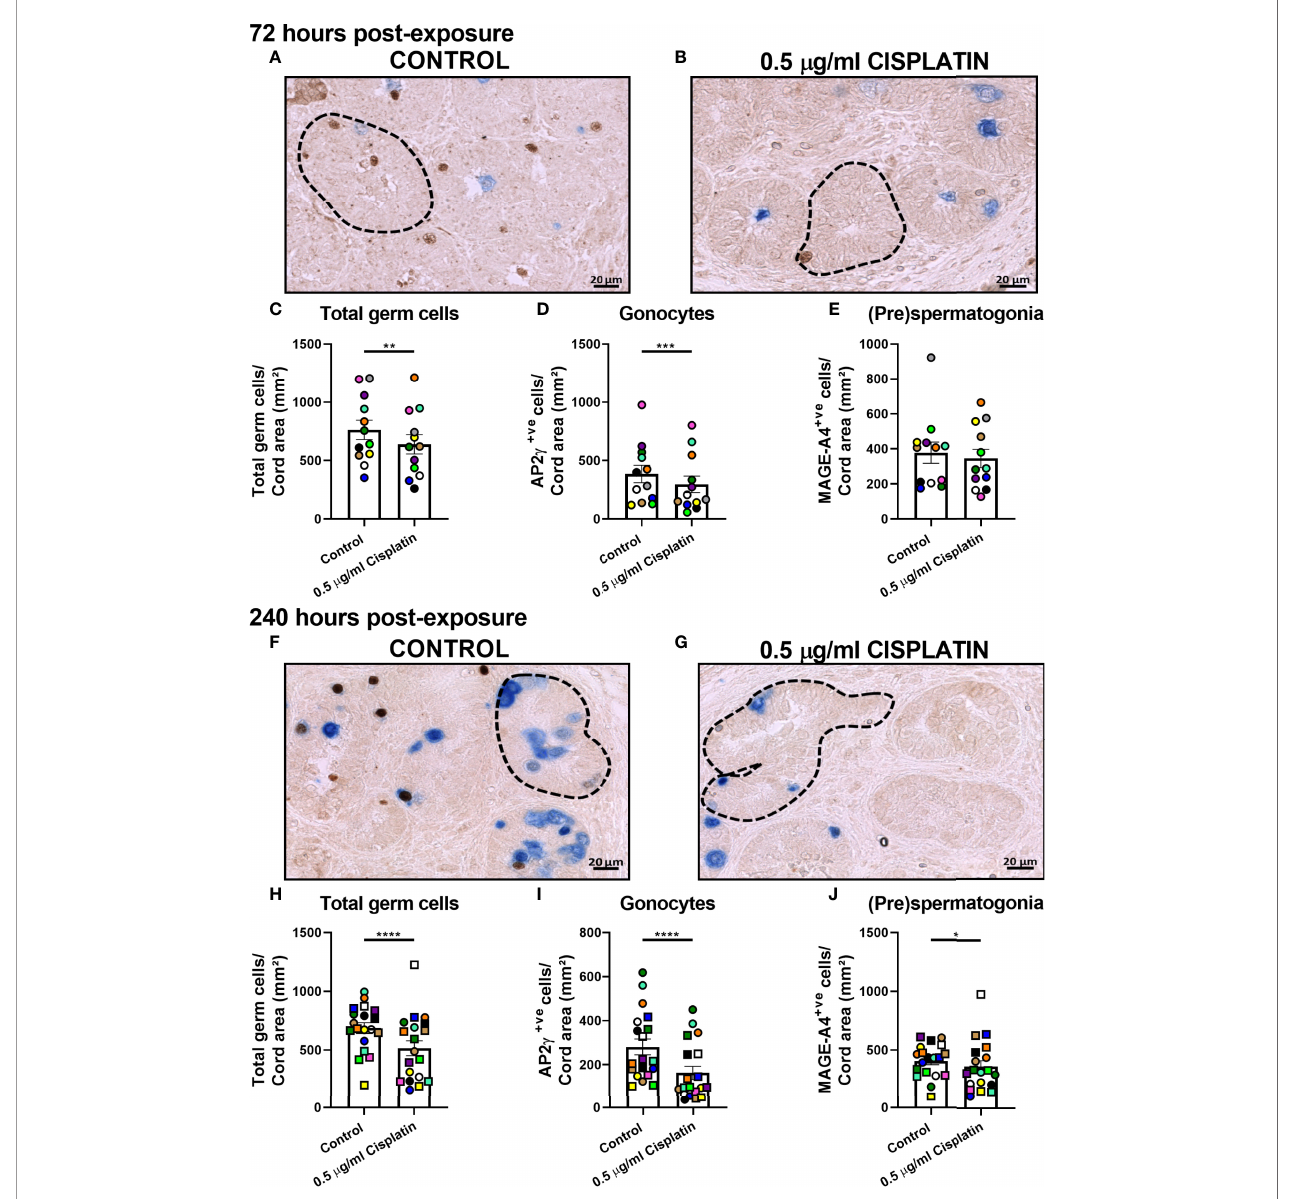
FIGURE 2 | Pooled data on effects of exposure to cisplatin on germ cell number in human fetal testicular tissues at 72 and 240 hours post-exposure. Immunohistochemical staining for gonocytes (AP2 g +; brown) and (pre)spermatogonia (MAGEA4+; blue) in the human fetal testis in vehicle control (A) and cisplatin-exposed (B) tissues at 72 hours; and in vehicle control (F) and cisplatin-exposed (G) tissues at 240hours post-exposure. Scale bars represent 20 m m. Dotted lines outline seminiferous cords. Total number of germ cells (C) , gonocytes (D) and (pre)spermatogonial (E) at 72 hours post-exposure. Total number of germ cells (H) , gonocytes (I) and (pre)spermatogonial (J) at 240 hours post-exposure. Data analysed using two-way ANOVA. *p<0.05, **p<0.01, ***p<0.001, ****p<0.0001. Values shown are means ± SEM and each data point represents the mean value for all fragments obtained from an individual fetus